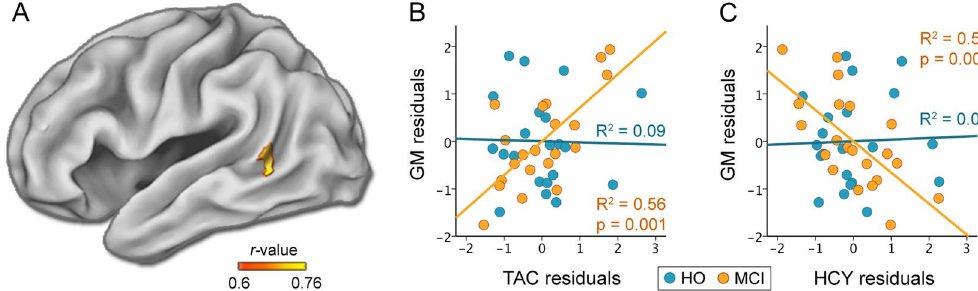
Figure 3. Correlations between HCY/TAC levels and cerebral GM. ( A ) Significant results derived from a linear regression between TAC and GM (p < 0.05; FWE corrected) in MCI. Scatter plots of TAC ( B ) or HCY ( C ) against GM for HO (in blue) and MCI (in orange). The variables included in the scatter plots correspond to the standardized residuals from a simple regression with age as independent variable. The coefficients of determination (R 2 ) and probability (p value) for each group are also